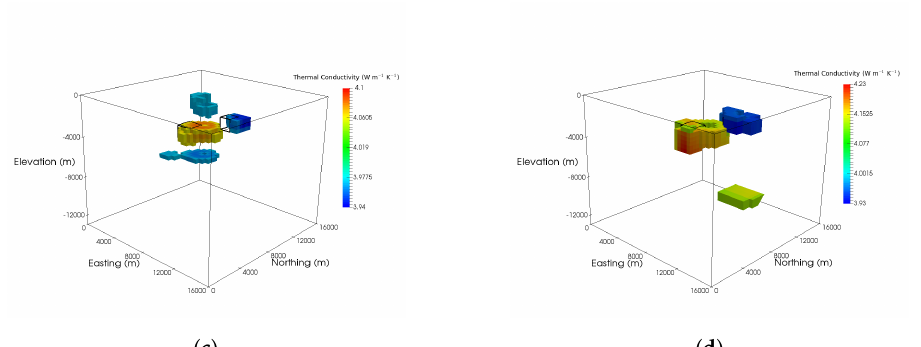
Figure 4. ( a ) Inversion result for borehole temperature data in the nine-well configuration with p = 2. Anomalous zones of conductivity are located near the true anomalies. Additional low conductivity “lobes” are located above and below the positive anomaly. The recovered conductivities are close to the background conductivity. ( b ) Inversion result for borehole temperature data in the nine-well configuration with p = 1. Compared to the p = 2 result, the false “lobes” are less pronounced and the conductivity values contrast more strongly with background. ( c ) Inversion result for five-well configuration with p = 2. Compared to the nine-well results, the anomalies are less well-defined horizontally and they contrast less with the background. ( d ) Inversion result for borehole temperature data in the five-well configuration with p = 1. Like the nine-well results, the “lobes” are less pronounced in the p = 1 result than in the p = 2 result and the conductivity contrast is greater. The anomalies are less well-defined horizontally for the five-well configuration,